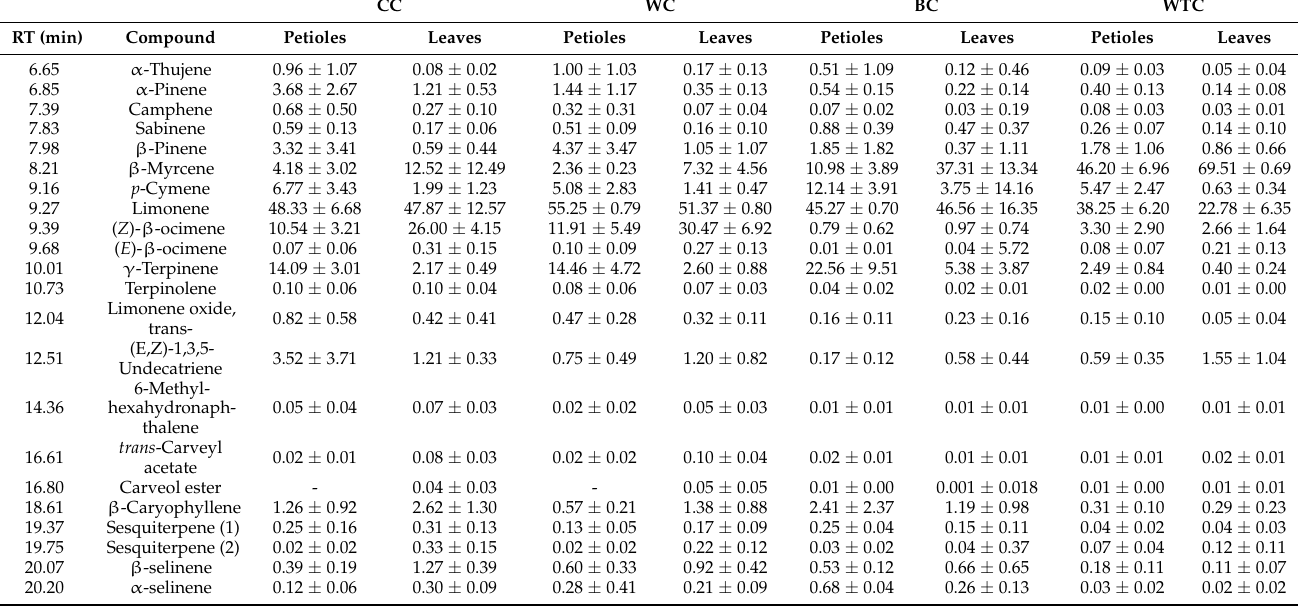
Table 1. Volatile profiles of celery petioles or leaves: observed retention time (RT (min)), assigned chemical structure and mean relative (%) peak area and related standard deviation in the GC/MS chromatograms for each variety: common celery (CC), white celery “Sedano Bianco di Sperlonga” (WC), black celery “Sedano Nero di Torricella Peligna” (BC) and wild type celery